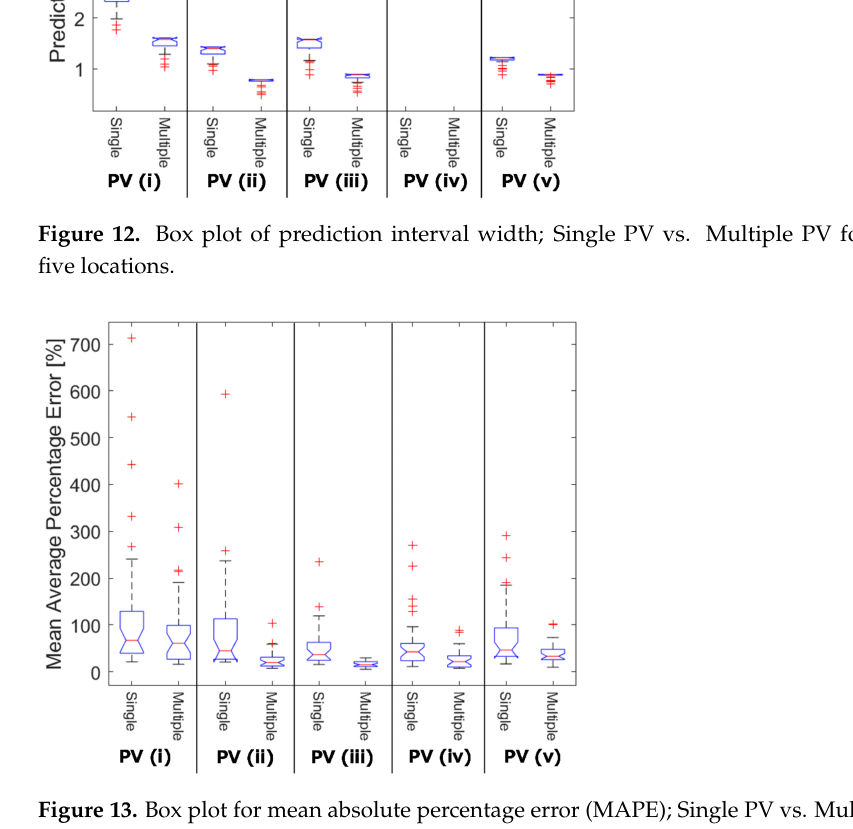
Figure 13. Box plot for mean absolute percentage error (MAPE); Single PV vs. Multiple PV forecast model at five locations.